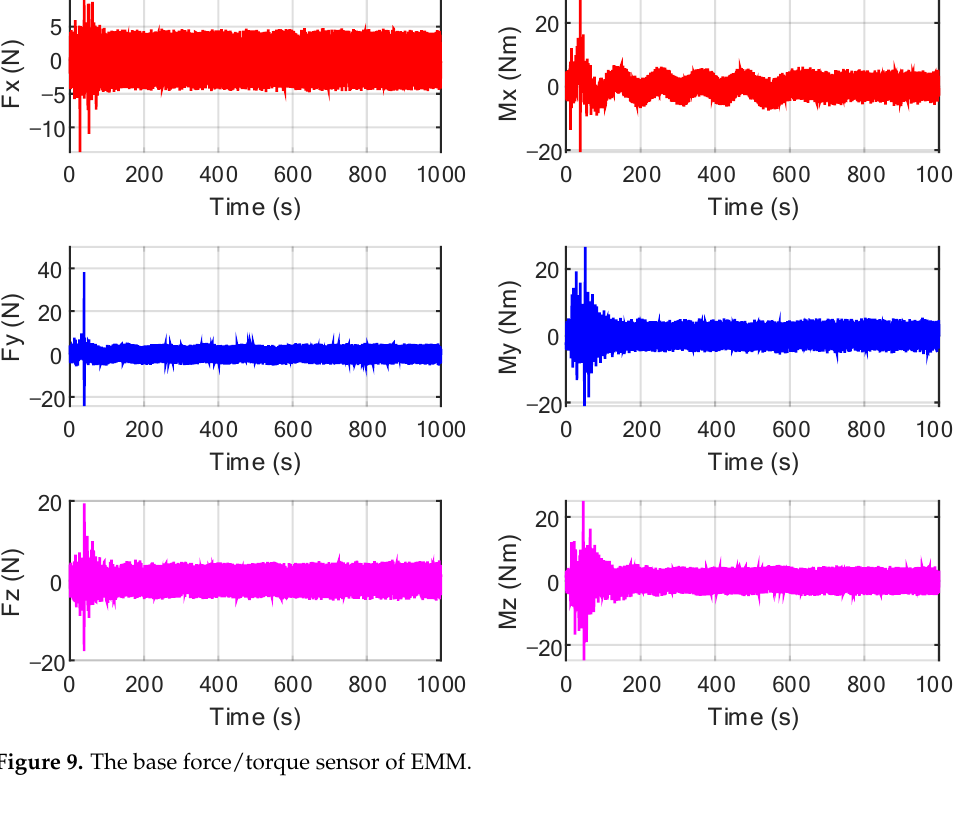
Figure 9. The base force/torque sensor of EMM.